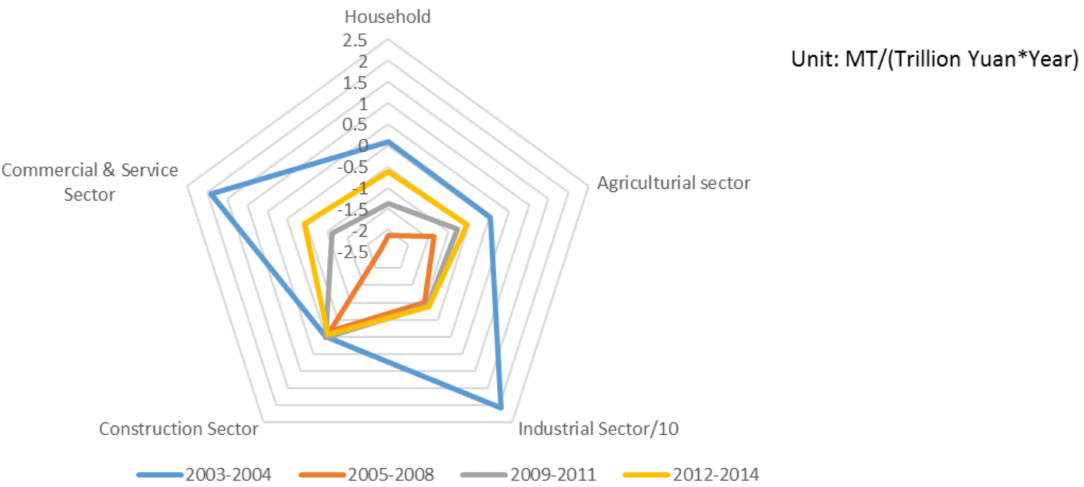
Figure 12. The Average Phase Contributions of Various Sectors to China’s Economic Carbon Intensity